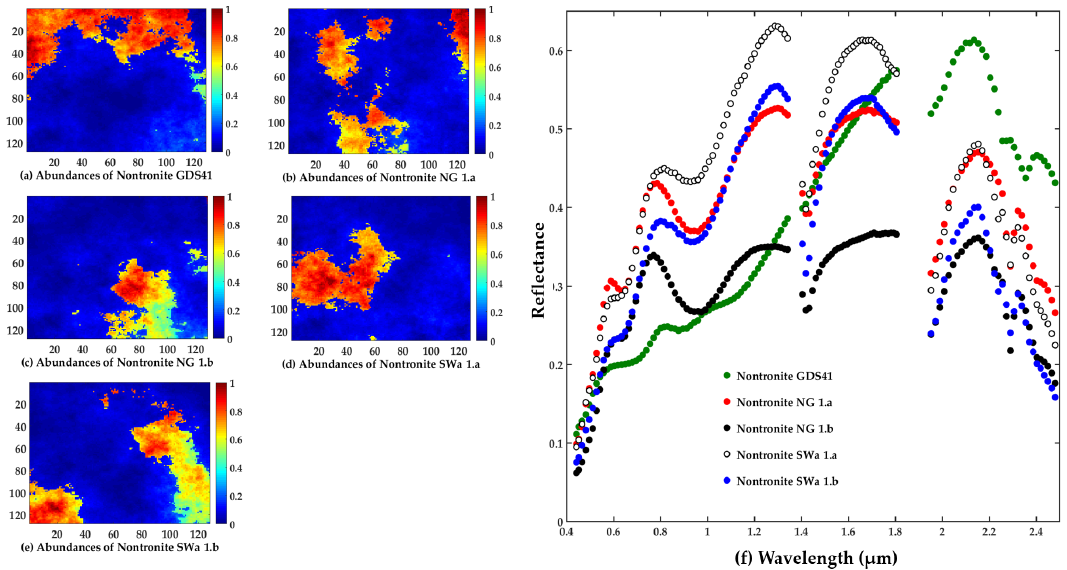
Figure 5. True fractional abundances of the materials used to generate a geological dataset with spectrally similar materials: ( a ) Nontronite GDS41; ( b ) Nontronite NG 1.a; ( c ) Nontronite NG 1.b; ( d ) Nontronite SWa 1.a; and ( e ) Nontronite SWa 1.b; and their spectral profiles ( f